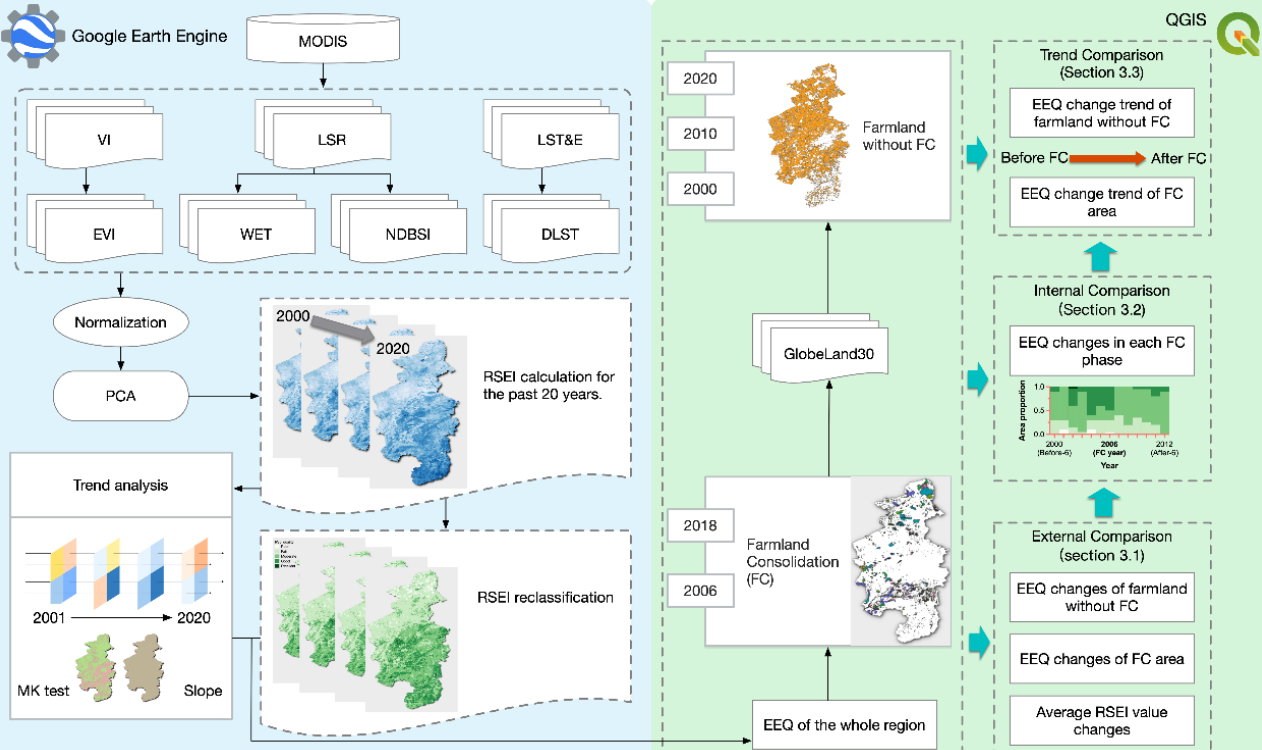
Figure 2. The technique flowchart. MODIS, Moderate-Resolution Imaging Spectroradiometer prod- uct; VI, vegetation indices; LSR, land surface reflectance; LST&E, land surface temperature and emissions; EVI, enhanced vegetation index; WET, humidity component; NDBSI, normalized differ- ence built-up and soil index; DLST, daytime land surface temperature; PCA, principal component analysis; RSEI, remote sensing ecological index; MK test, Mann–Kendall trend test; Slope, Theil–Sen slope estimator; EEQ, ecological–environmental quality; FC, farmland